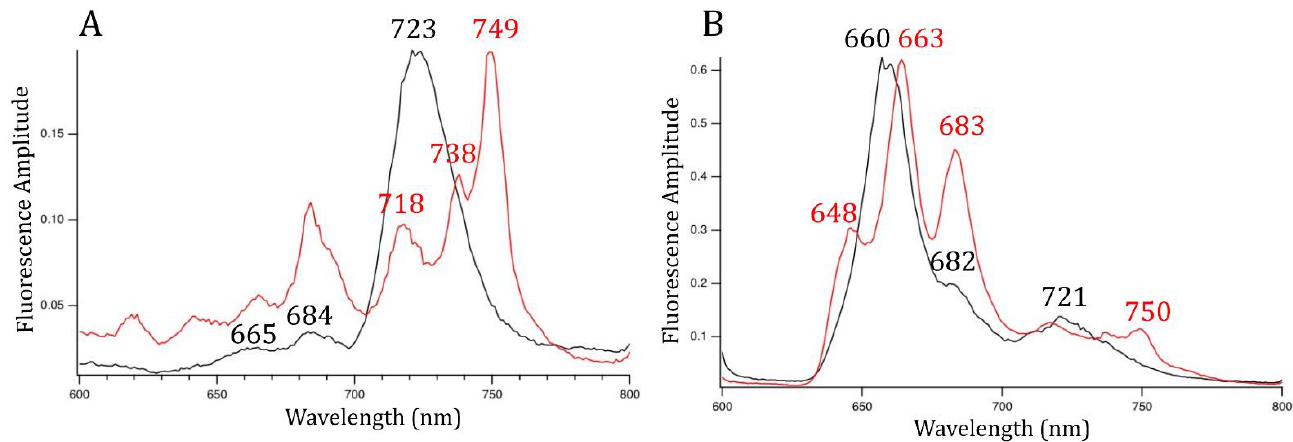
Figure 4. 77 K fluorescence emission spectra for Chroococcidiopsis G-MTQ-3P2 cultures grown in VL (black line) and FRL (red line). ( A ) Excitation wavelength at 440 nm to excite Chls preferentially. ( B ) Excitation wavelength at 590 nm to excite PBPs preferentially. Cells were resuspended in 60% glycerol at OD 780 of 0.7. Each spectrum was the average of three measurements.